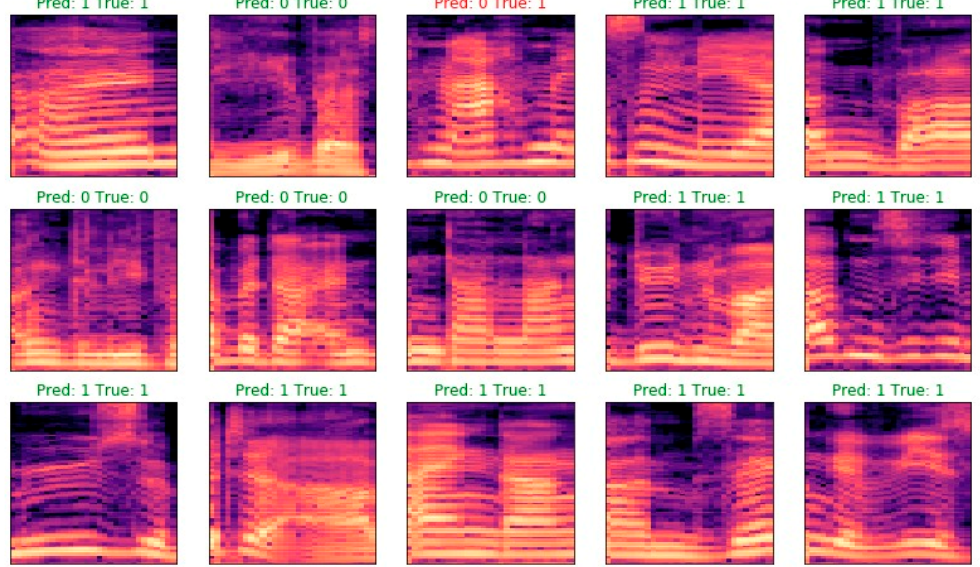
Figure 7. Examples of classifications for Experiment